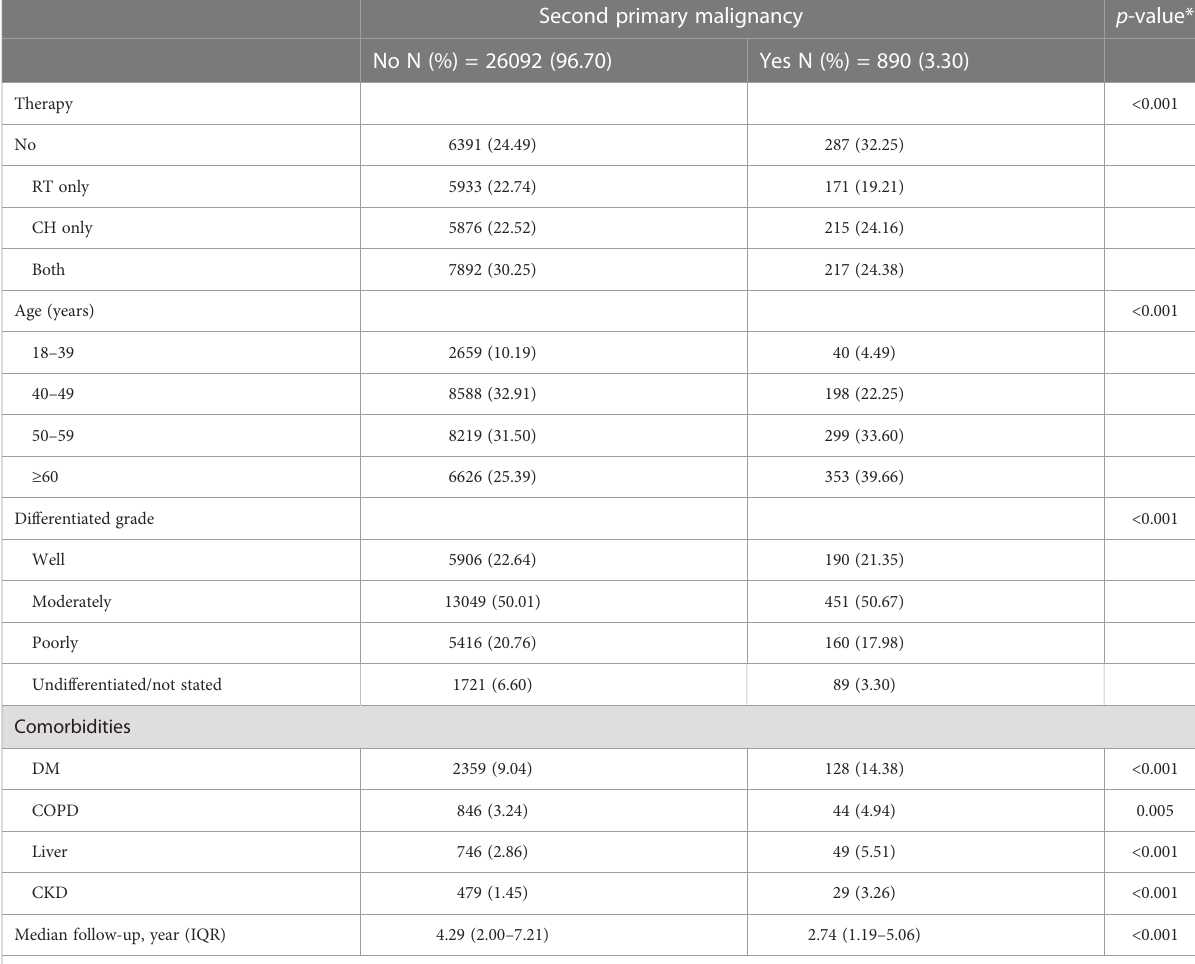
TABLE 4A Risk of second primary malignancies in patients with stage I breast